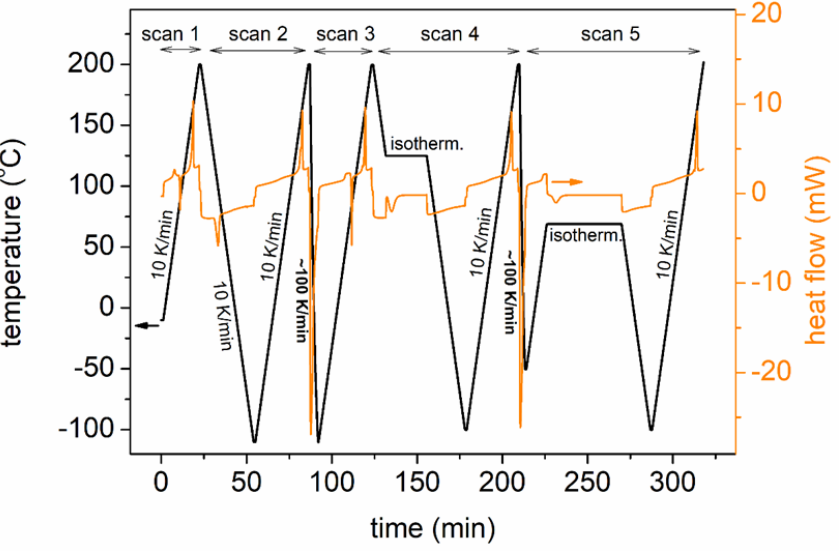
Figure 2. (Left axis, black line) The time–temperature profiles for Scans 1–5 of the DSC measurements. (Right axis, orange line) A representative example of the recorded heat flow against time is shown.